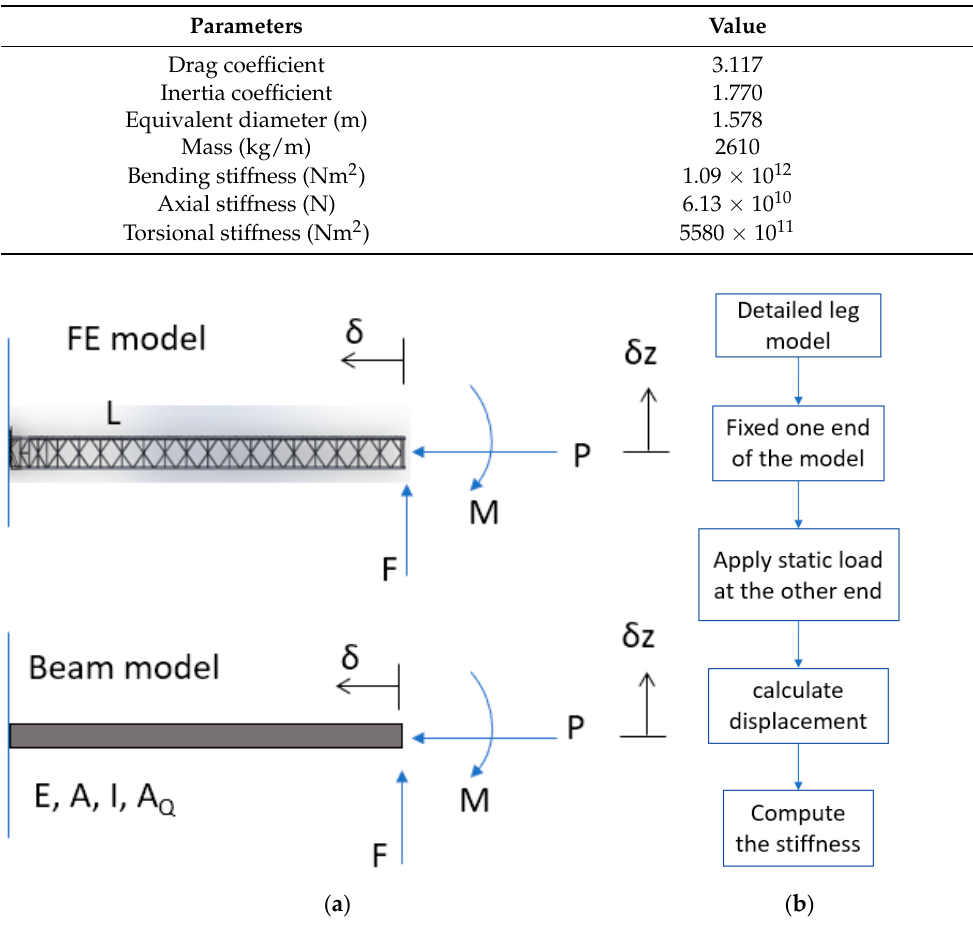
Figure 4. Procedure for deriving equivalent stick model for SEUs: ( a ) application of forces for deriving equivalent stiffness, ( b ) flowchart for deriving equivalent stiffness.